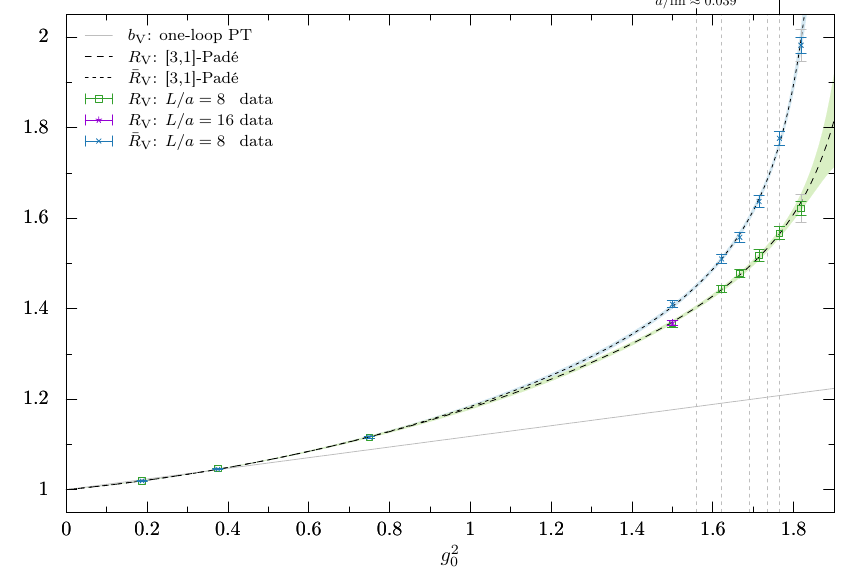
(cid:22) R V and V in comparison to the known perturbative 3 : 4 ; 3 : 46 ; 3 : 55 ; 3 : 7 ; 3 : 85 2 f